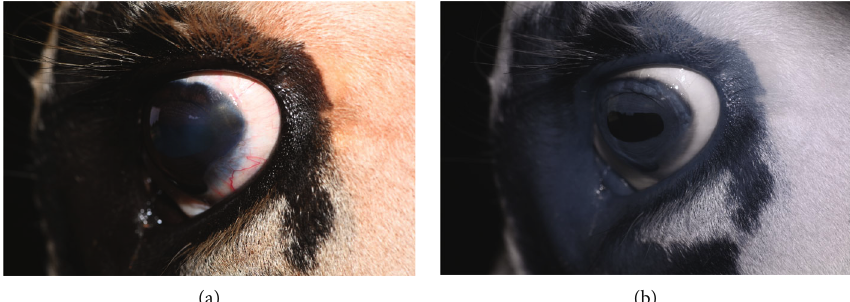
Figure 5: Color (a) and infrared (b) imaging of the left eye 11 months after surgery. Faint fi brosis is noted along the temporal limbus with no evidence of tumor